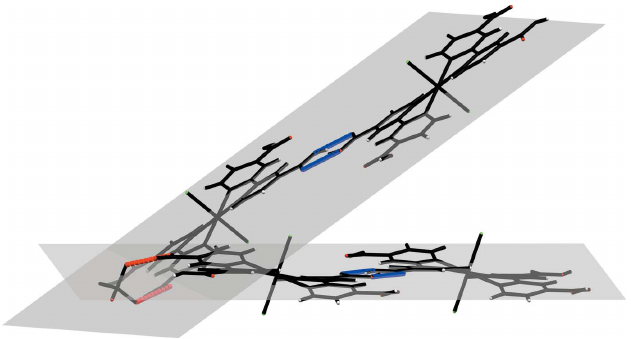
Figure 2 View of the planes along which two sets of ribbons formed by the hydrogen-bonded carboxylic groups C4O1O2H2 propagate (hydrogen bonds are represented by blue dashed lines). Red dashed lines show the interactions between the perchlorate anion and the C12O3O4H4 carboxylate